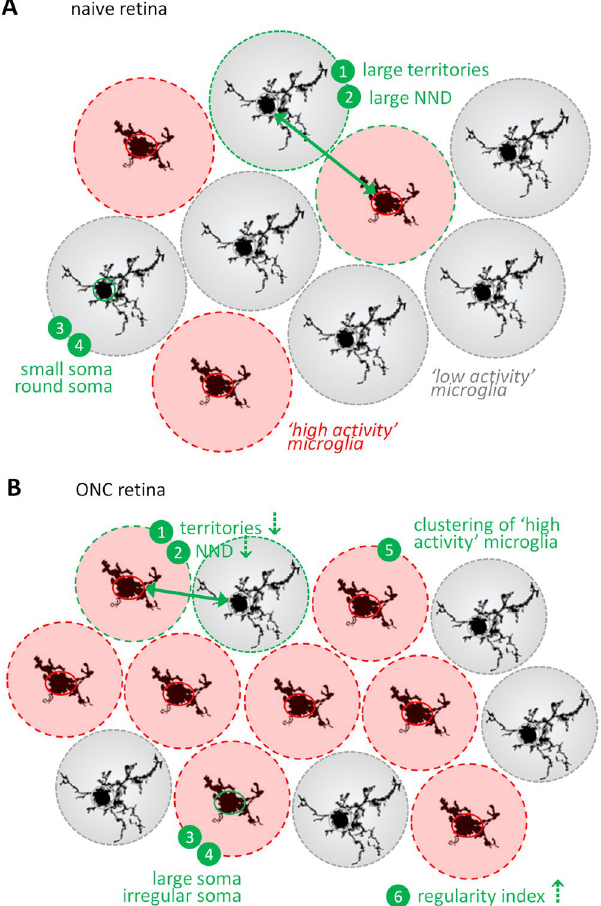
Figure 6. Summary figure integrating all findings from this study. ( a ) In a naive retina, microglia typically have small somata and large territories, corresponding to a ‘low activity’ status (grey). They are regularly interspersed with a minority of ‘high activity’ cells (red). ( b ) At day 4 post ONC, microglia density has increased and the majority of the microglia has adopted a ‘high activity’ phenotype, characterized by a reduction in their territory, enlargement of their cell body and a more irregular cell shape. Furthermore, although ‘low activity’ and ‘high activity’ microglia are regularly spaced, ‘high activity’ microglia tend to